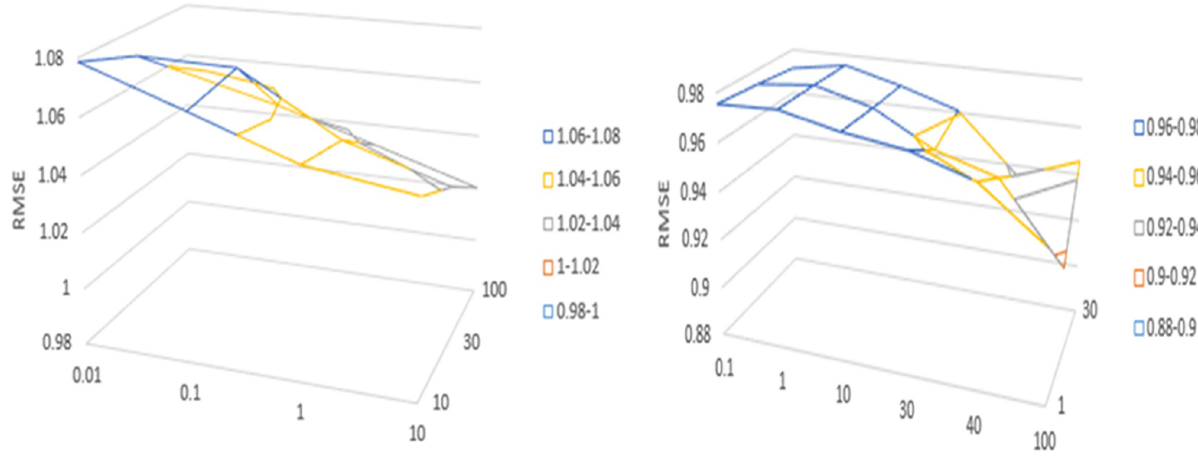
Fig 6. Validation RMSE as a result of varying λ u , λ v .